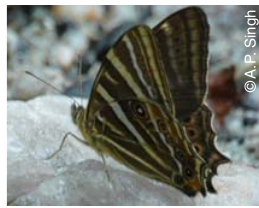
Image 138. Treble Silverstripe, Lethe baldeva aisa